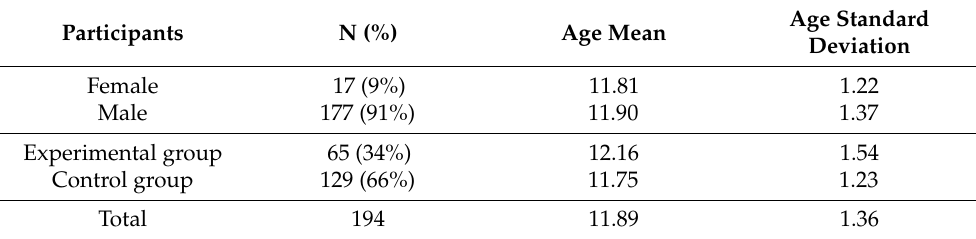
Table 1. Description of the study